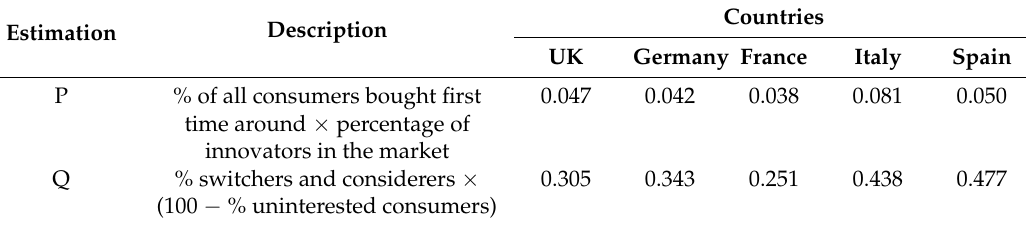
Table 2. Proxies for P and Q based on the experimental